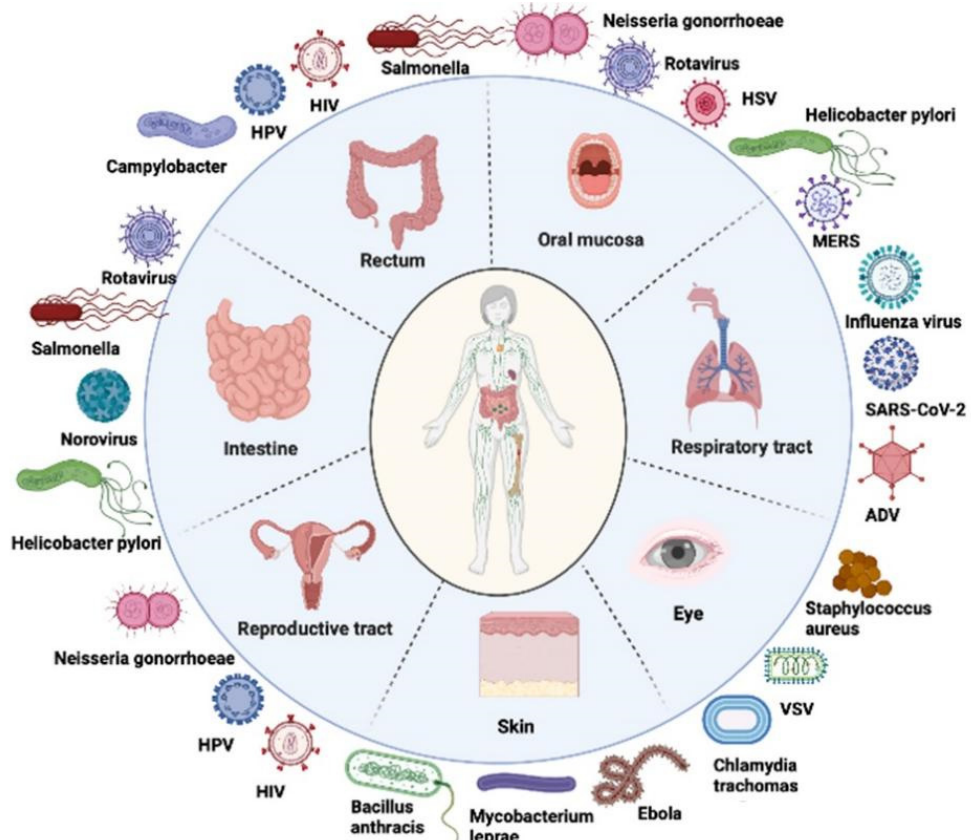
Figure Figure 1. Numerous pathogenic microbes can invade the human body through different mucosal routes.